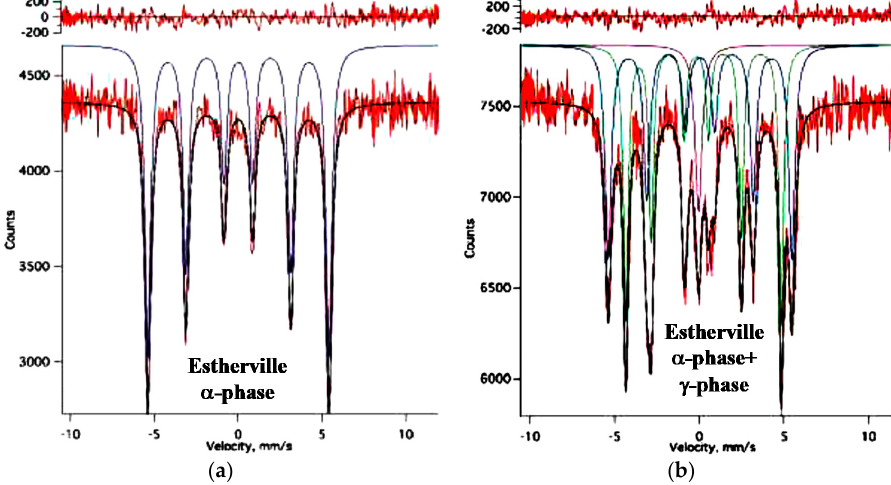
Figure 22. Room temperature synchrotron Mössbauer spectra of Estherville Mes-A3/4: α -phase area ( a ) and α -phase + γ -phase area ( b ). Indicated components are the results of the fits. Differential spectra are shown on the top. Adapted from the Supporting Information in [44].